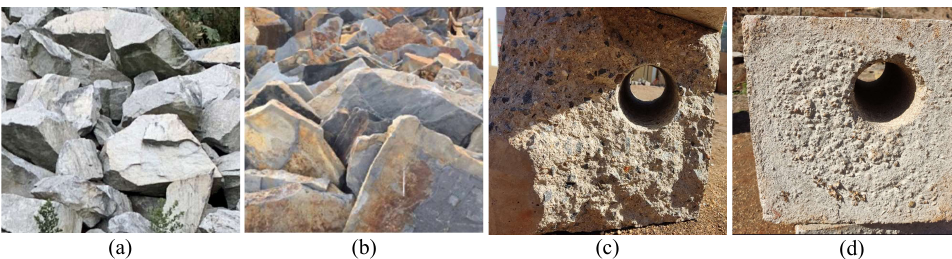
Figure 6. Rock and concrete specimens for evaluation of observer-based MWD system: ( a ) quarry